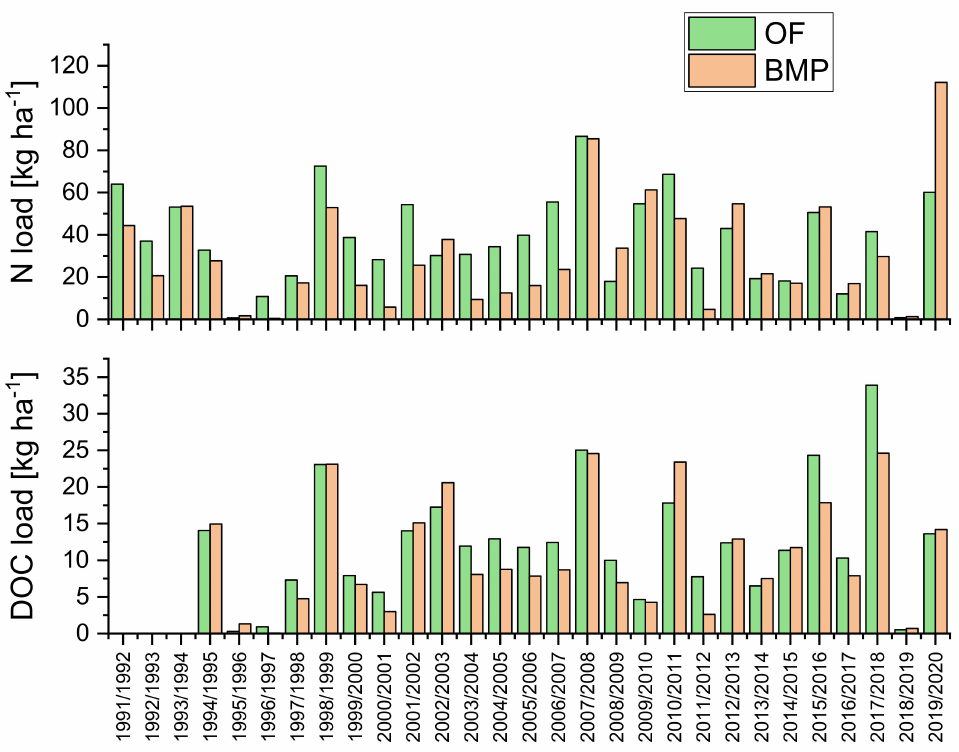
Figure 7. Loads of Nitrogen (N) and Dissolved Organic Carbon (DOC) of Organic Farming (OF) and Best Management Practice (BMP) for the study period